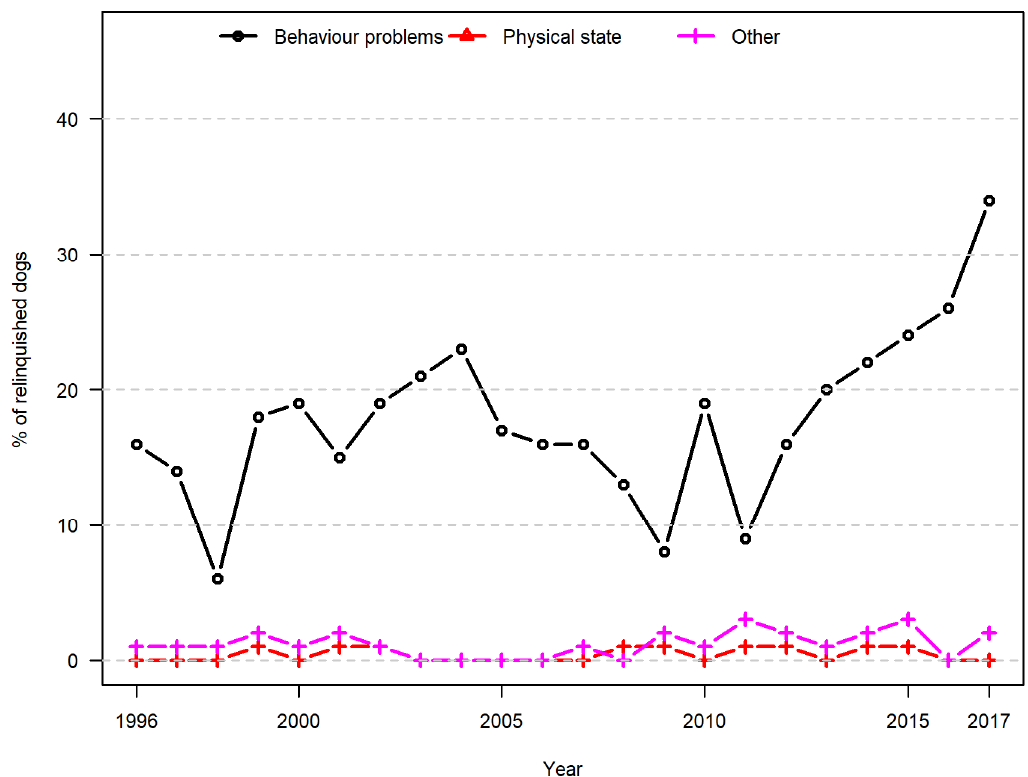
Figure 5. Animal-related reasons for relinquishment (dogs). Proportional distribution of reported animal-related reasons for the relinquishment of dogs in a Danish animal shelter from 1996 to 2017.